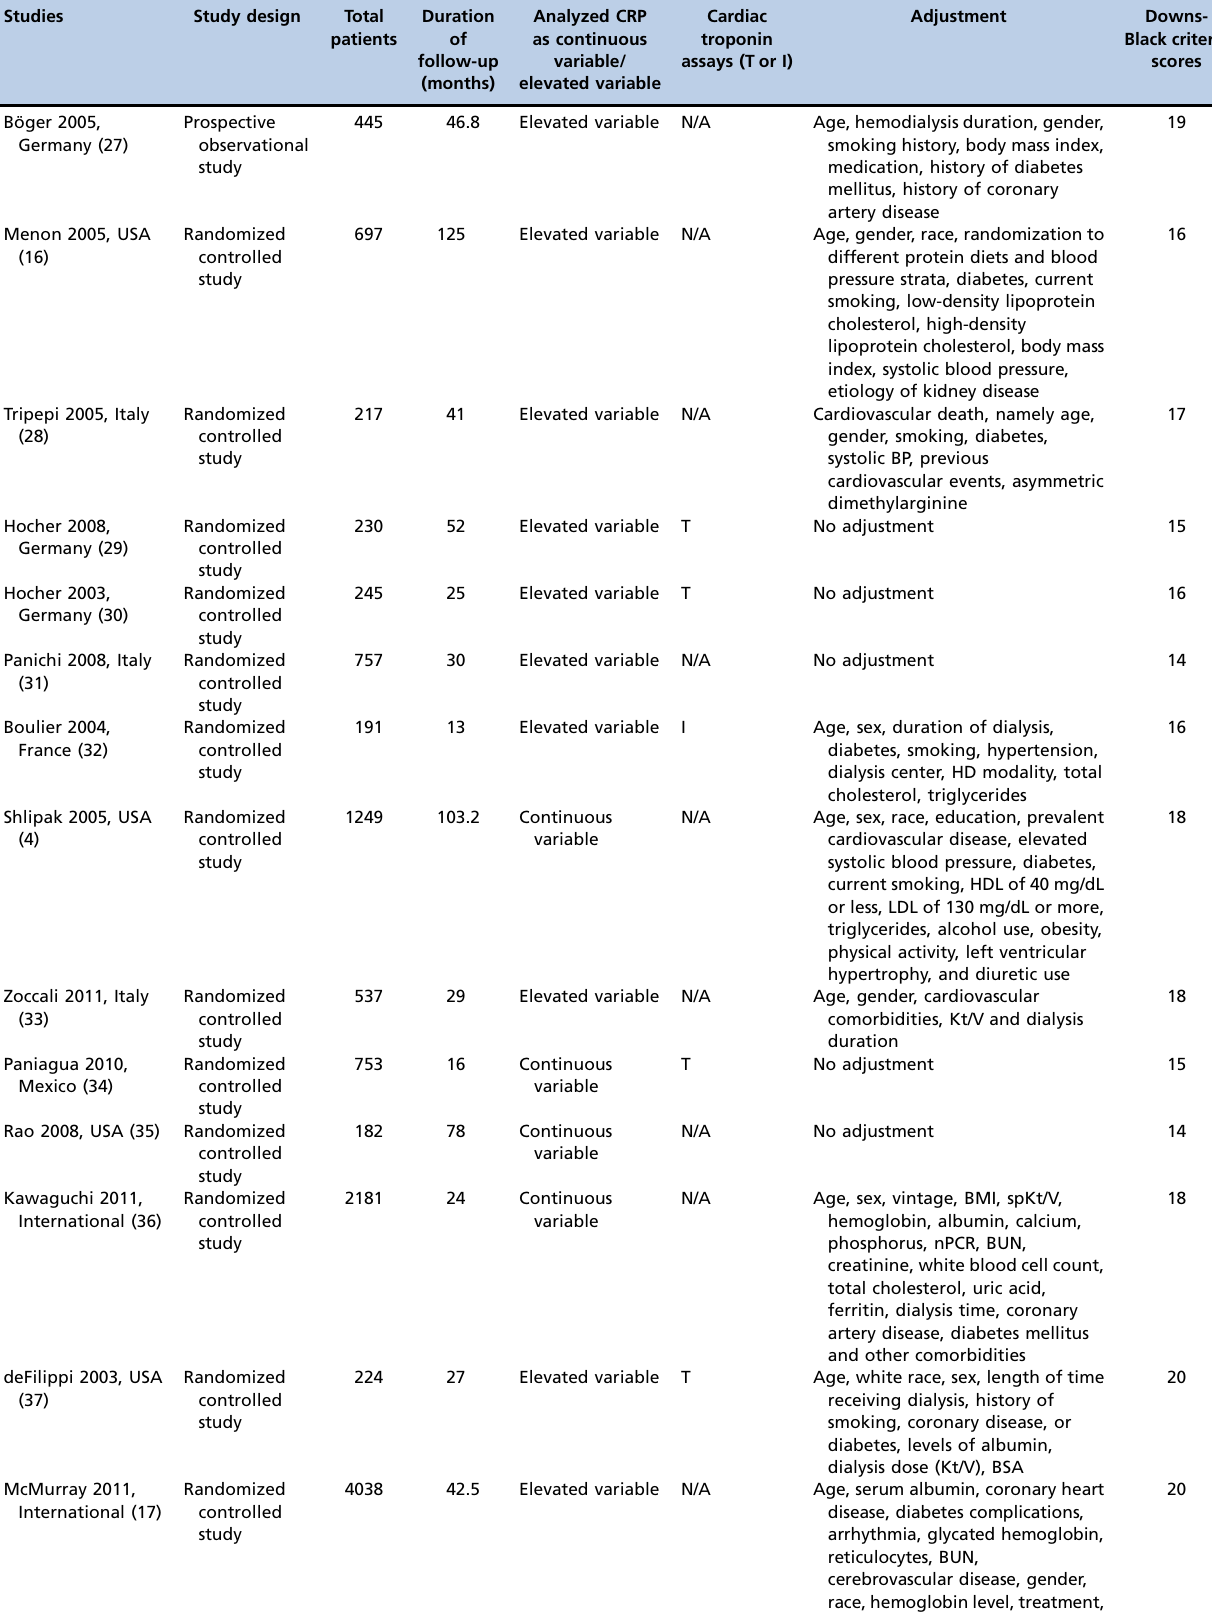
Table 1 - Characteristics of the included